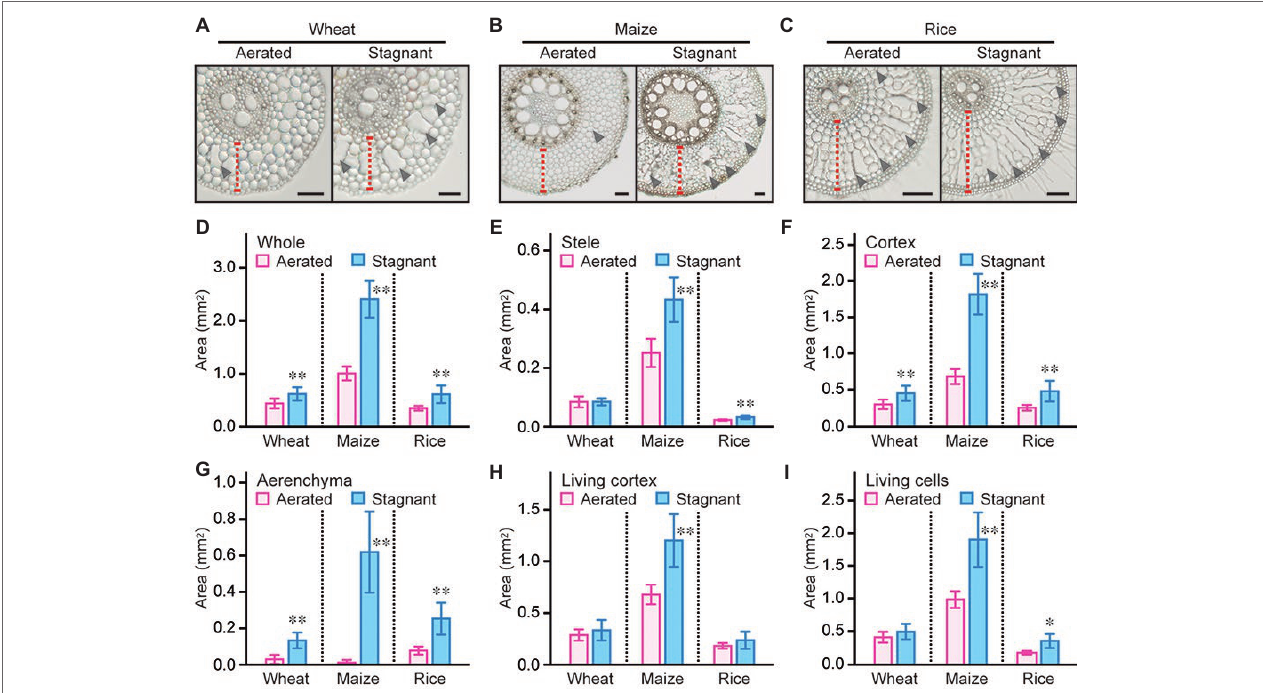
FIGURE 2 | Area of each tissue in adventitious roots of wheat, maize, and rice. Cross sections at 50 mm from the tips of adventitious roots of wheat (A) , maize (B) , and rice (C) under aerated or stagnant conditions. Cortex cell layers and lysigenous aerenchyma are indicated by red dashed lines and black arrowheads, respectively. Bars = 100 μ m. Areas of whole root (D) , stele (E) , cortex (F) , aerenchyma (G) , living cortex (cortex minus aerenchyma) (H) , and living cells (whole root minus aerenchyma) (I) at 50 mm from the tips of adventitious roots of wheat, maize, and rice seedlings under aerated or stagnant conditions. Nine-day-old wheat, maize, and rice seedlings were further grown under aerated or stagnant conditions for 7 days. Significant differences between aerated and stagnant conditions at p < 0.01 and p < 0.05 (two-sample t -test) are denoted by ∗∗ and ∗ , respectively. Values are means ± SD ( n = 9).